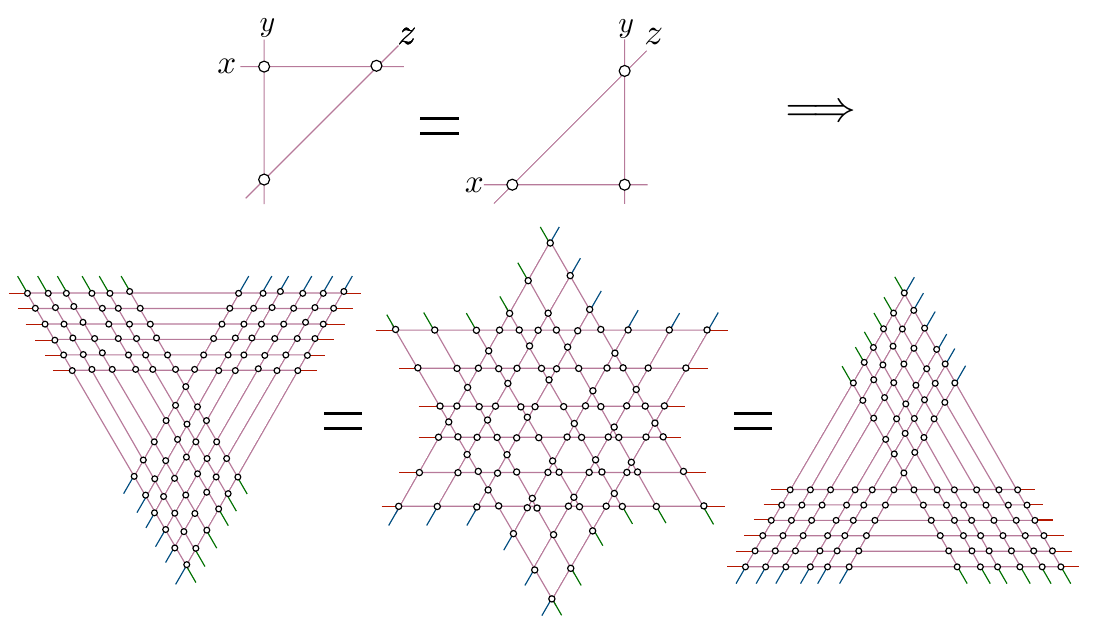
Figure 2 . The PSU(2|2) vertex satisfies the Yang-Baxter relation illustrated in the first line. Simply put, the partition function is invariant under translating lines across vertices. These allows for many possible rewritings of the partition function, as expressed in the second line. The term on the left-hand side corresponds to the second line of (2.6). The next two terms give alternative representations whose explicit form we hope is clear from the picture. In particular, the middle shape relates the hexagon partition function to a Hubbard-type model in a Kagome-type